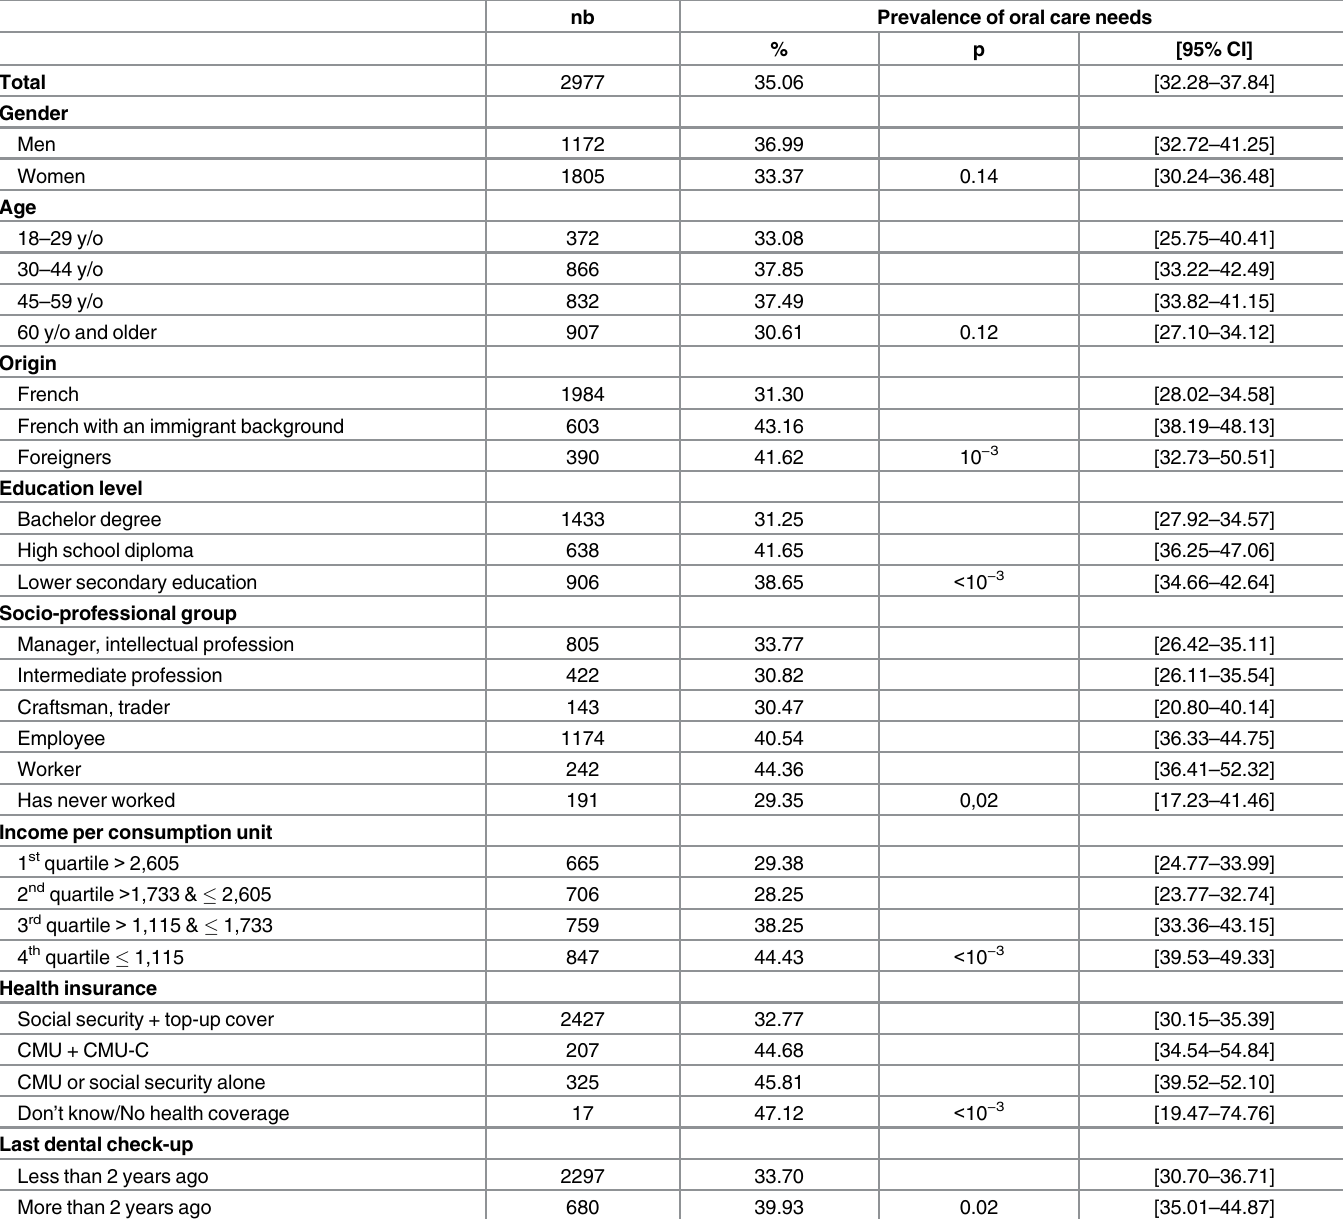
Table 1. Prevalence of the declared need for oral care according to the characteristics of the study population (French SIRS cohort, 2010).